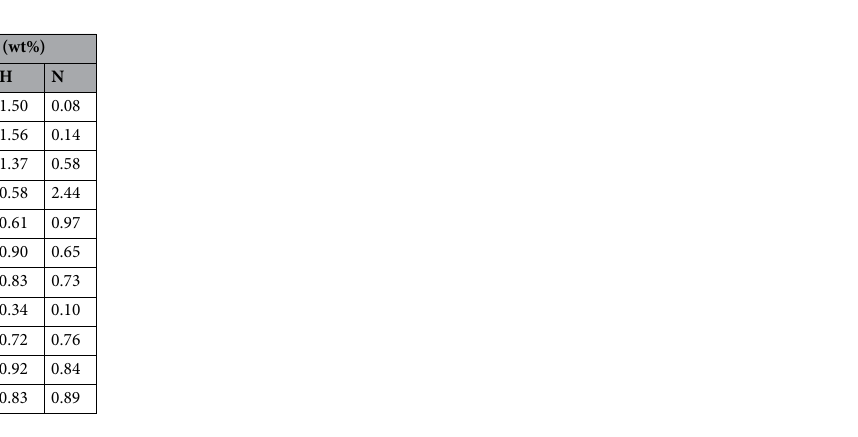
Table 1. Elemental composition of EG and graphene foams obtained with different solvents and holding times in the microwave reactor.